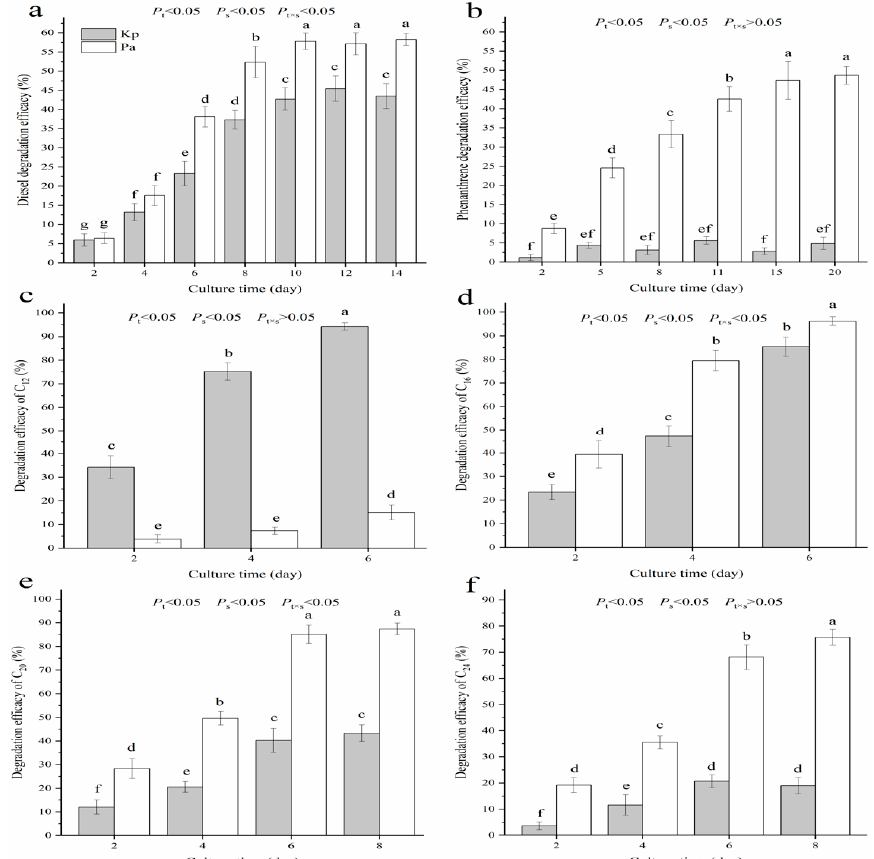
Figure 1. Degradation efficacy of Kp and Pa strains for: ( a ) diesel, ( b ) phenanthrene, ( c ) n-dodecane (C 12 ), ( d ) n-hexadecane (C 16 ), ( e ) n-eicosane (C 20 ), and ( f ) n-tetracosane (C 24 ). The corresponding hydrocarbon degradation efficacy values represent the mean ± SD of three independent replicates (n = 3). In each data sample, P t , P s , and P t×s represent the P value of time, strain and interaction between the strains, respectively. Different letters above the columns represent significant differences according to Fisher’s HSD test ( p < 0.05).